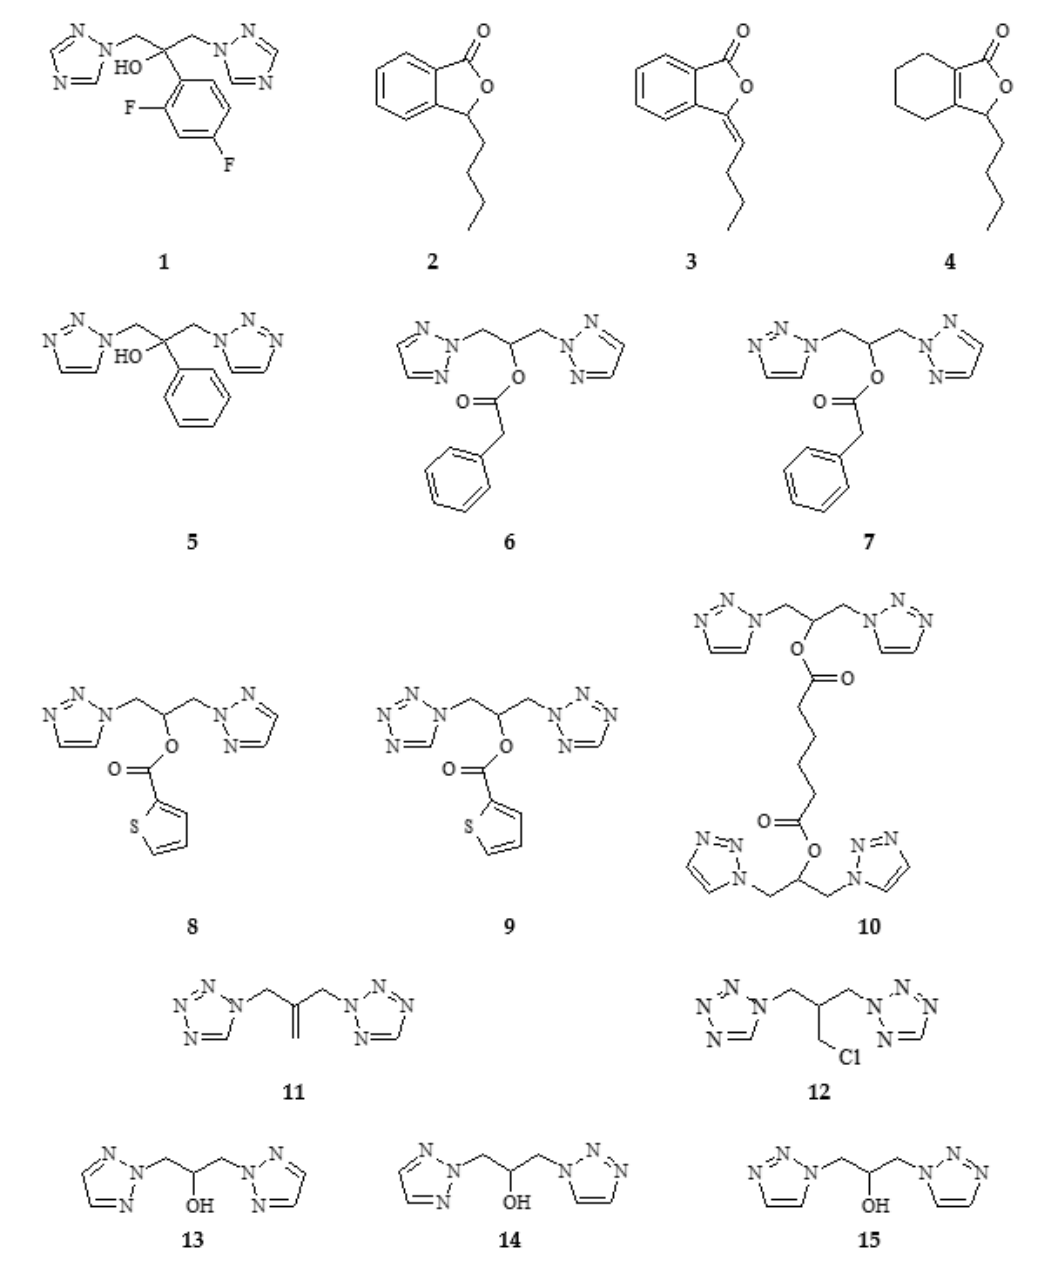
Figure 4. List of fluconazole ( 1 ), phthalide lactones 2 – 4 , and designed fluconazole analogues 5–15 used in biological tests.